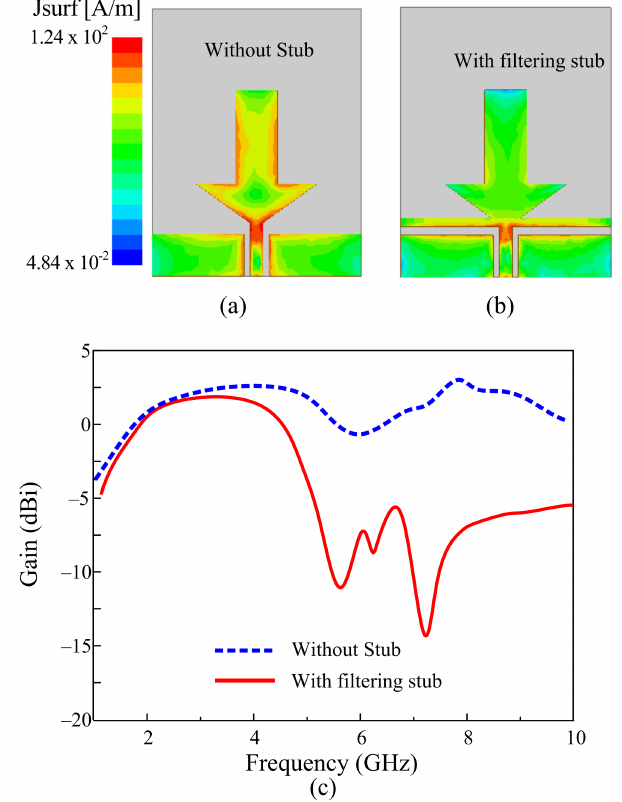
Figure 4. Surface current distribution of the antenna at 8.5 GHz. ( a ) Antenna without stub. ( b ) Antenna with stub. ( c ) Gain of the